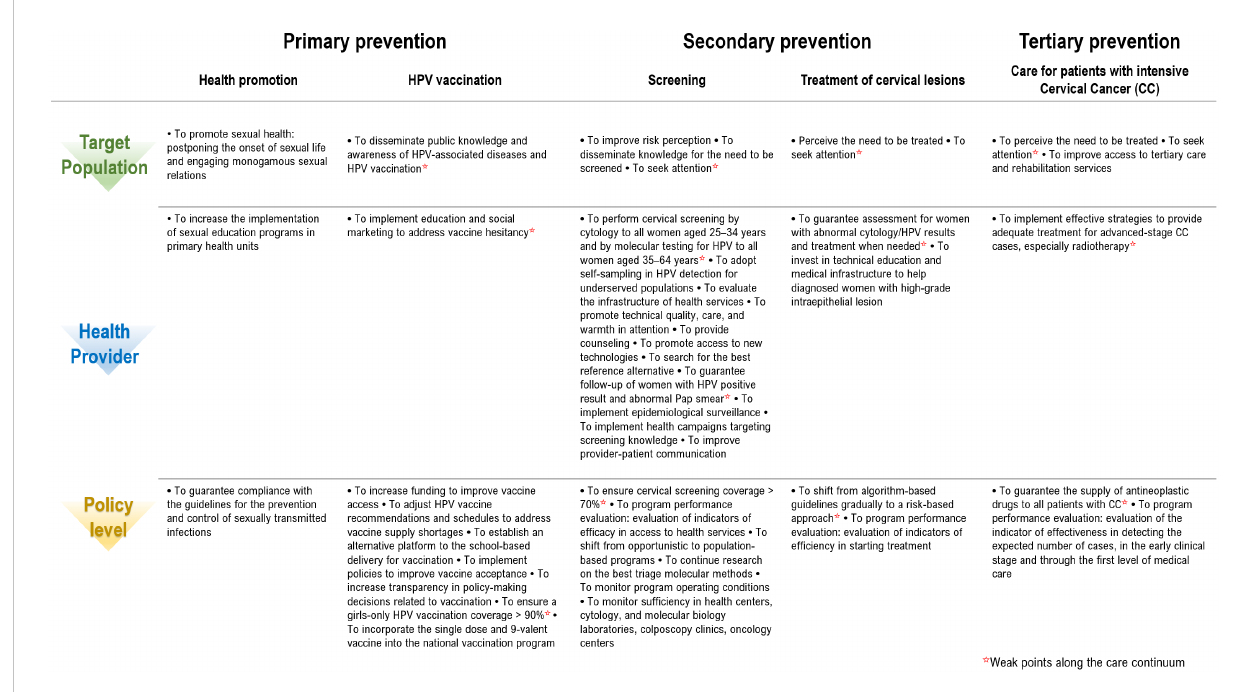
FIGURE 4 Process model of the cervical cancer prevention program in Mexico. The proposed strategies should be considered by health care providers and policymakers along the cascade of care to move toward the goal of eliminating cervical cancer in Mexico, as well as the critical control points in Mexico ’ s cervical cancer prevention program process model. *Weaknesses along the continuum of